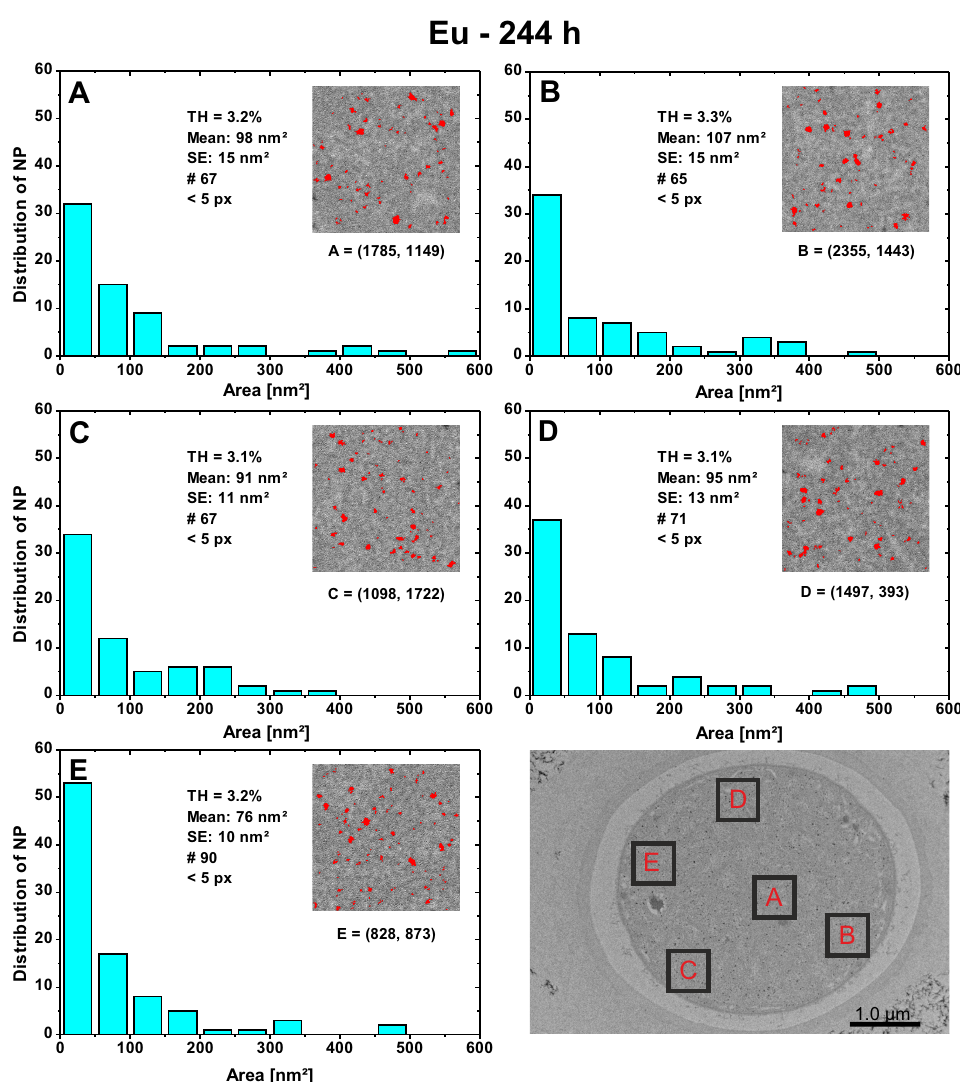
Figure 4. Local PSDs for Eu-NPs after 244 h growth time of five randomly selected 500 × 500 nm 2 areas ( A – E ) within the presented heterocyst No. 10. Indicated in the plots are the thresholds (TH), the mean values with the standard error of the mean (SE), the total number of particles detected (#), the lower measurement limit in pixels (px), and the local (x,y)-coordinates for each digital image